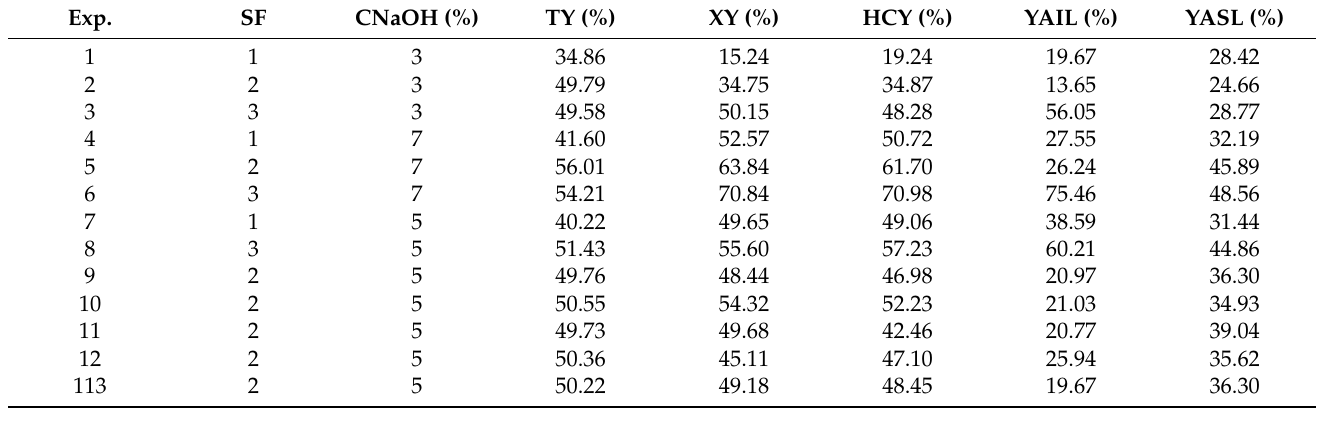
Table 4. Experimental results and conditions of hot alkaline extraction of wheat straw.